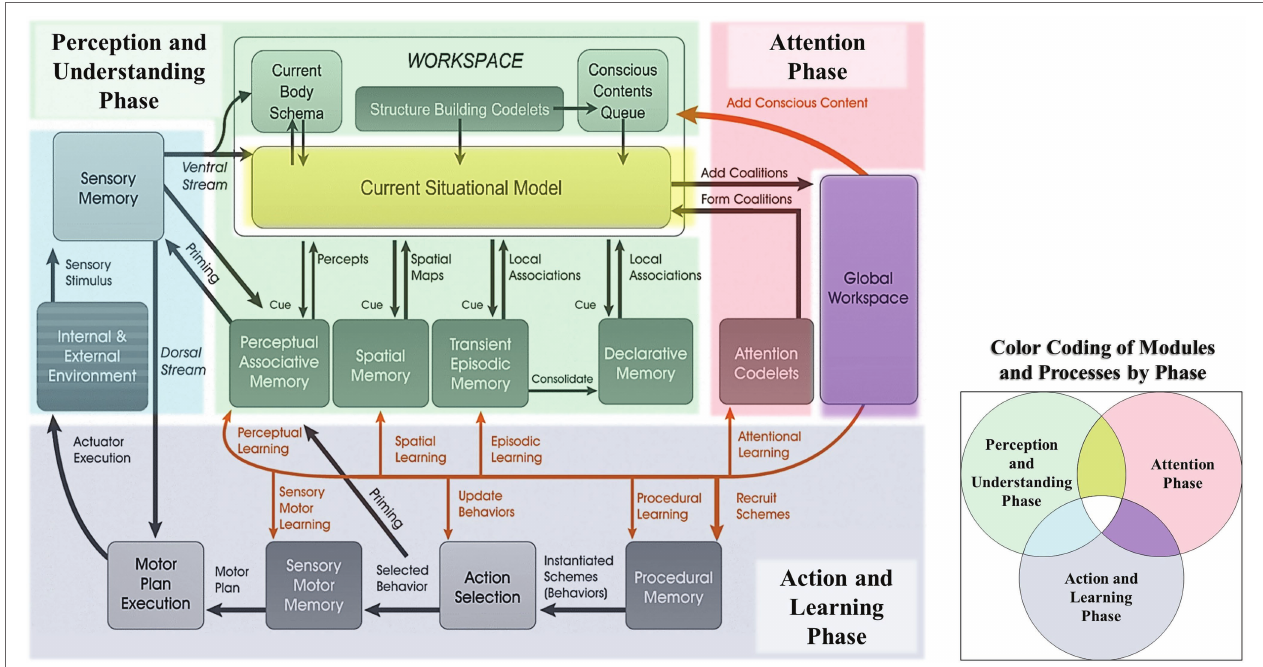
FIGURE 2 | The LIDA Cognitive Cycle Diagram color coded. Green modules are involved in the perception and understanding phase, pink modules in the attention phase, and grey modules are involved in the Action and learning